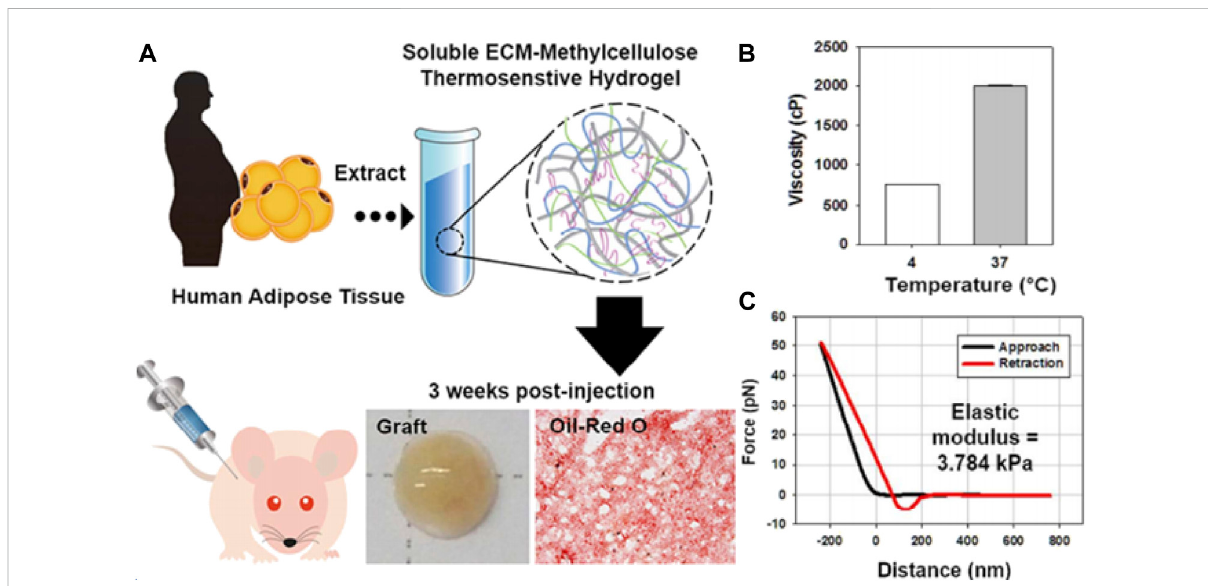
FIGURE 2 Representative studies of temperature-sensitive nanomaterials based on polysaccharide. (A) Cell-free hydrogel system based on a tissue- speci fi c extracellular matrix for in situ adipose tissue regeneration. (B) Viscosity and (C) AFM-based force-distance curves of sECM-MC hydrogels. Reprinted with permission from Kim J. S. et al (2017). Copyright © 2017 American Chemical Society.